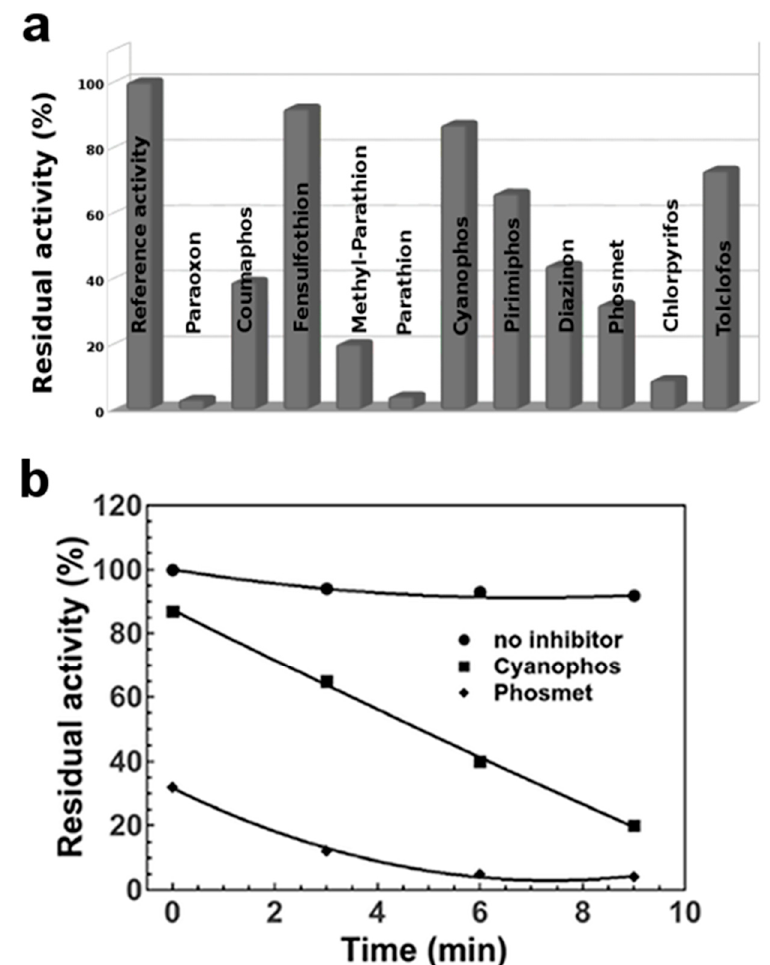
Figure 4. Robotic approach for OP detection in water. ( a ) Plot of EST2 residual activity in absence (Reference activity) and presence of different pesticides oxidized with NBS, measured using the robotic workstation. ( b ) Plot of EST2 residual activity measured using the robotic workstation at different inhibition times in absence and in presence of cyanophos and phosmet oxidized with NBS.